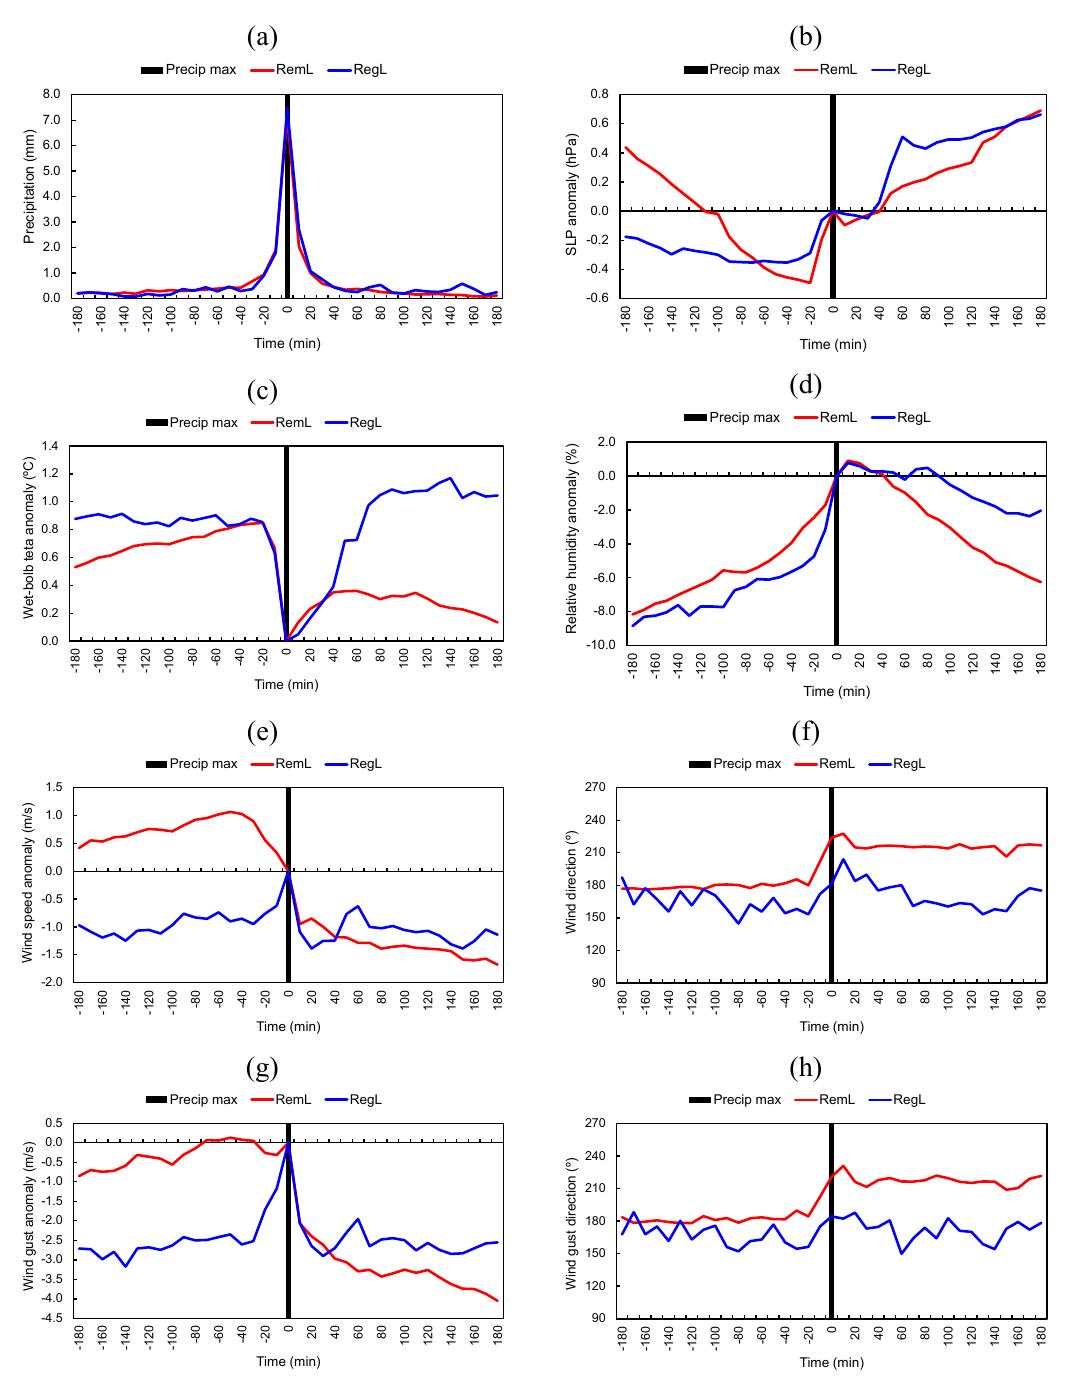
Figure 8. Mean chronological series over a 6-hour period centered at the instant of the event occurrences (133 events with 10 min of precipitation ≥ 5.0 mm, 26 RegL and 107 RemL), for the Porto weather station (545: Porto Pedras Rubras), shown for: ( a ) precipitation, ( b ) sea-level pressure anomaly (with respect to the event instant), ( c ) wet-bulb potential temperature anomaly, ( d ) relative humidity anomaly, ( e ) wind speed anomaly, ( f ) wind direction, ( g ) wind gust, ( h ) wind gust direction. The event occurrence is tracked with a vertical black line.